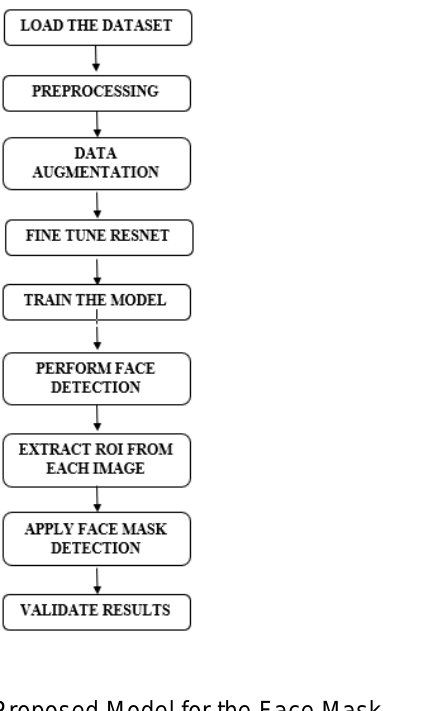
Figure 1. Proposed Model for the Face Mask Detection system